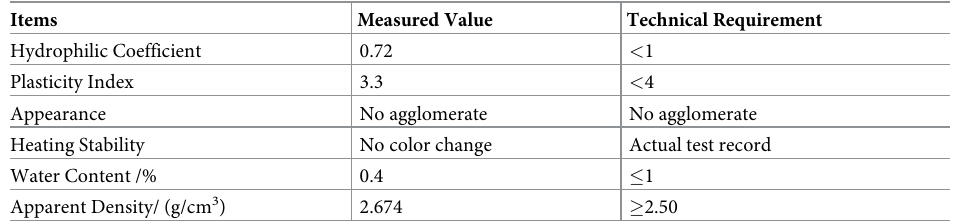
Table 6. The main technical performance of used mineral